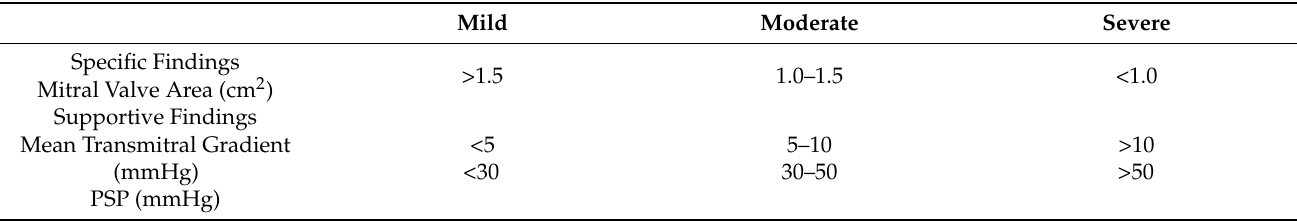
Baumgartnet et al. [10].